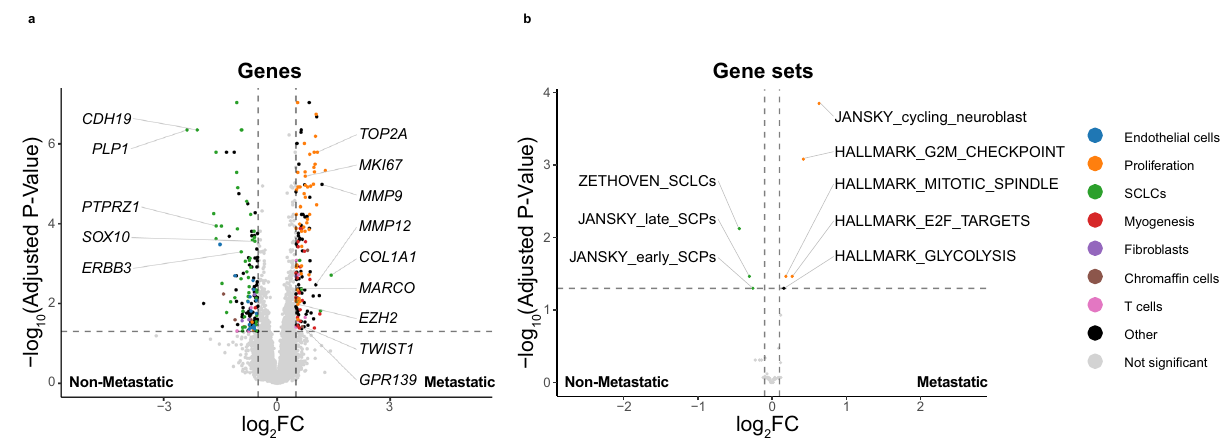
Fig. 8 | Differentially expressed genes and gene-set scores distinguishing non- metastatic and metastatic C1A ( SDHx ) PCPG in bulk tissue analysis. a Volcano- plot depicting DE genes between non-metastatic and metastatic PCPG (BH-adj. P - value<0.05, log 2 FC>0.5). b Differential GSVA scores for gene-sets observed